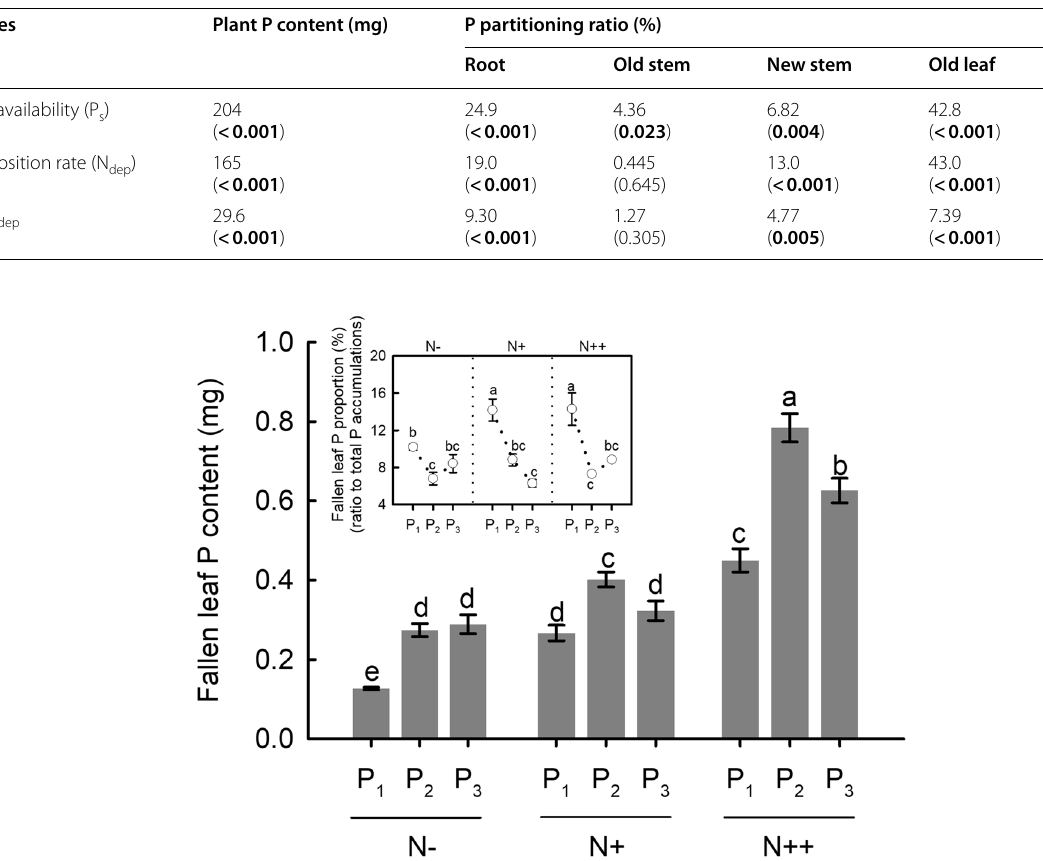
0.05). Vertical bars represent =